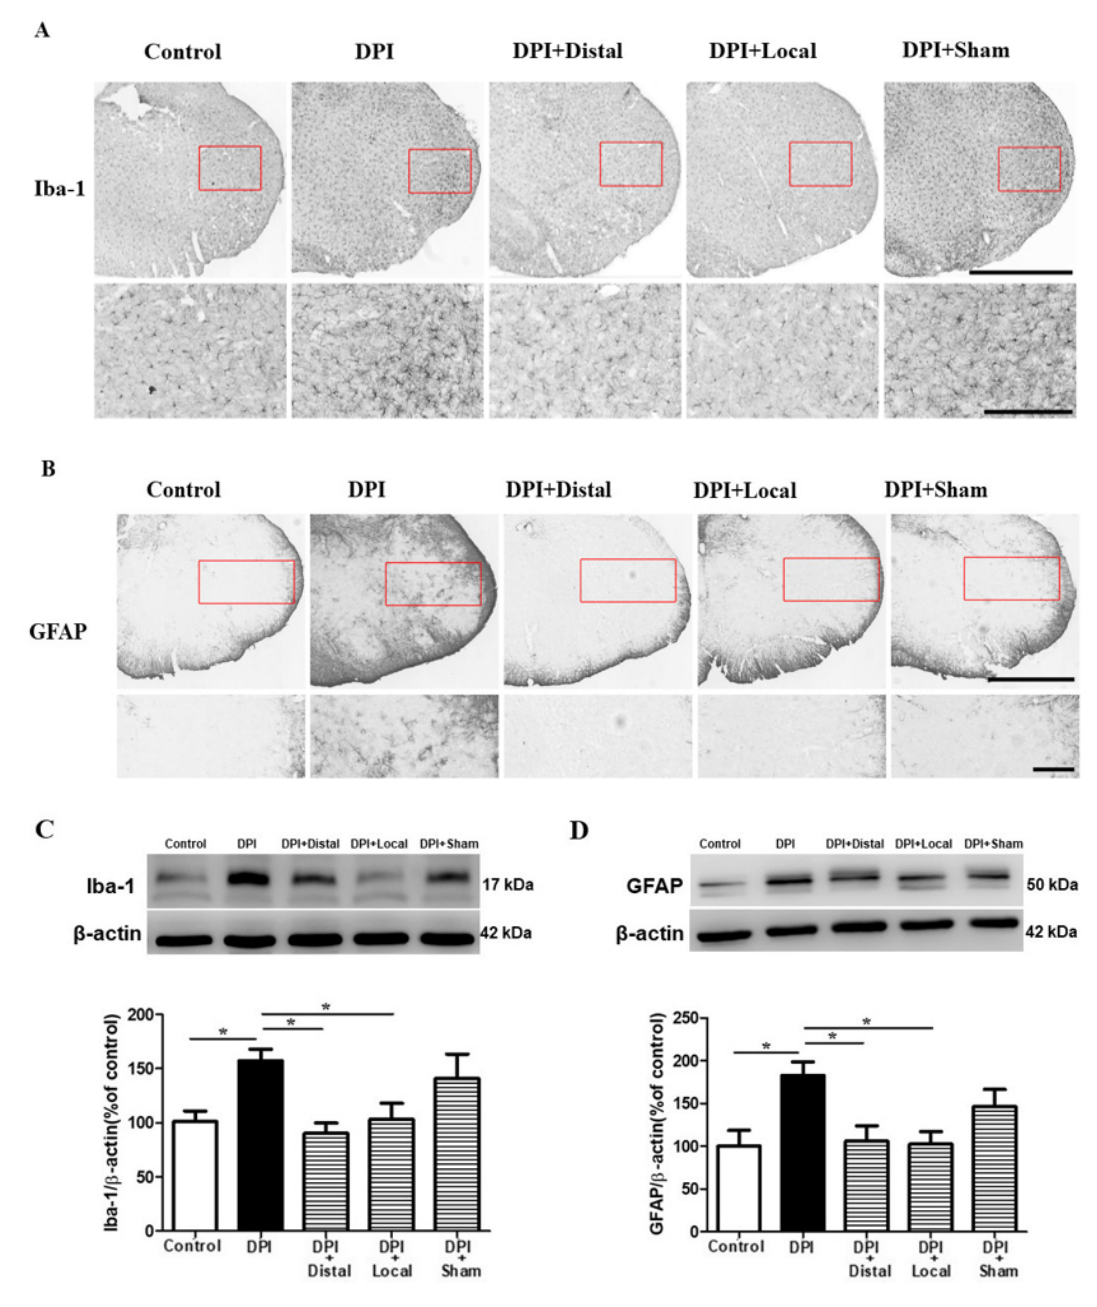
Figure 4. Verum (local and distal) EA inhibits DPI-induced microglial and astrocytes activation in the subnucleus caudalis (Vc). ( A , B ) Photomicrographs of Iba-1 and GFAP immunoreactivity, respectively, increased on day 21 after DPI in the Vc compared to controls, whereas verum (local and distal) EA downregulated the expression of microglia and astrocytes, while sham EA did not have such effect. ( C , D ) Illustrative Western blot bands, histogram and data summary depicting Iba-1 and GFAP expression, which are microglia and astrocytes markers respectively. Between-group comparisons for each group were performed by ANOVA, followed by Dunnett’s test (* p < 0.05, versus DPI group; n = 9 in each group). Scale bars = 1 mm (upper panel), 250 μ m (lower panel) A and B .